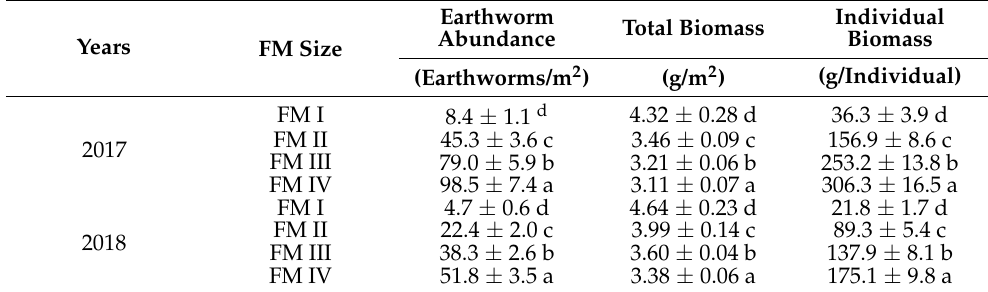
Figure 6. Effects of field margins (FM) size classes on the dynamic of earthworm abundance and adult rate in the rice-rapeseed system under rotary tillage. Data were medians and their 95% confidence intervals ( n = 3). Treatments having no letters in common represented significantly differences (S-N-K, p < 0.05). ( A – C ) represented the earthworm abundance in the area of 0–1 m, 2–3 m and 7–8 m from field edge respectively, and ( D – F ) represented the adult rate in the area of 0–1 m, 2–3 m and 7–8 m from field edge respectively. Table 2. Effects of field margins (FM) size on earthworm biomass at the maturity stage of a rice- rapeseed cropping